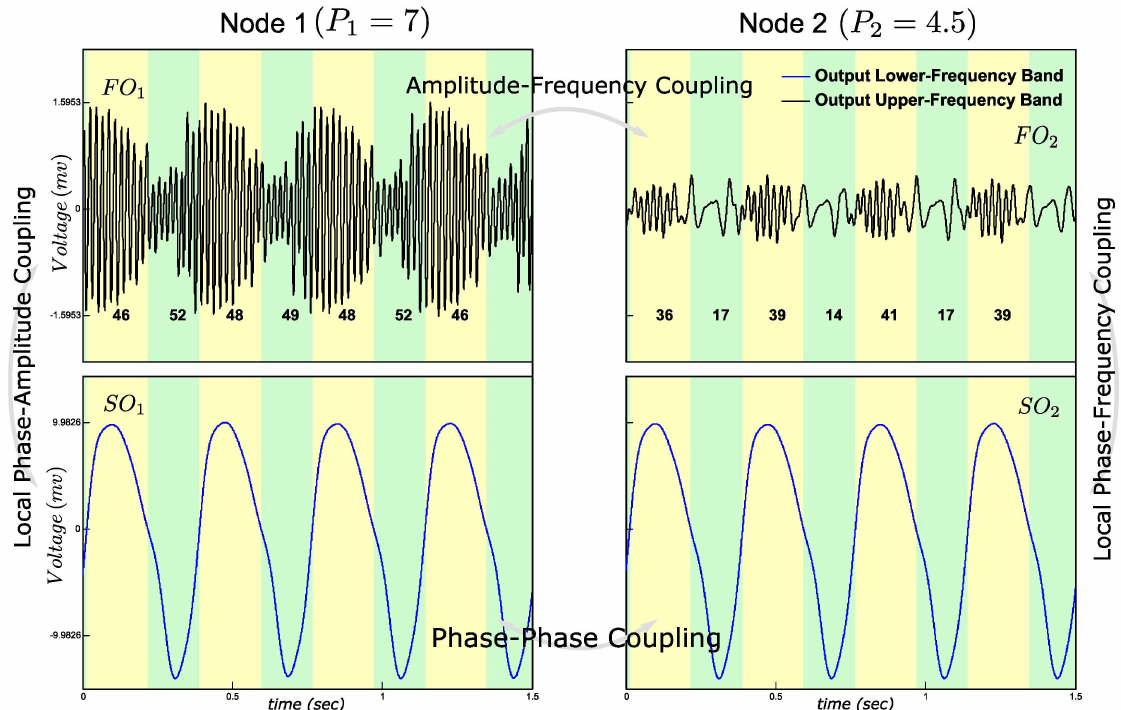
Fig 6. Amplitude-Frequency Coupling (AFC) simulation. The instantaneous amplitudeof FO 1 correlates with the synchronized SO 1 and SO 2 . The frequency of FO 2 is about constant whilethe frequencyof FO 1 varies for the synchronizedSO 1 and SO 2 . See averagenumber of zero crossings in FOs, indicatedas integersbelow the FO time waves.